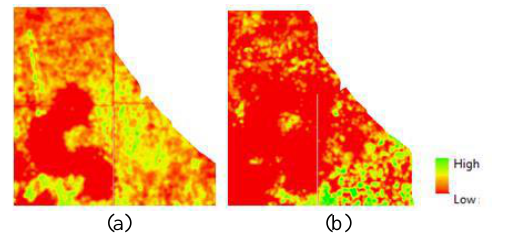
Figure 22. High density mature woody vegetation (a) located in the same area of high density of old forest vegetation (b) Vegetation